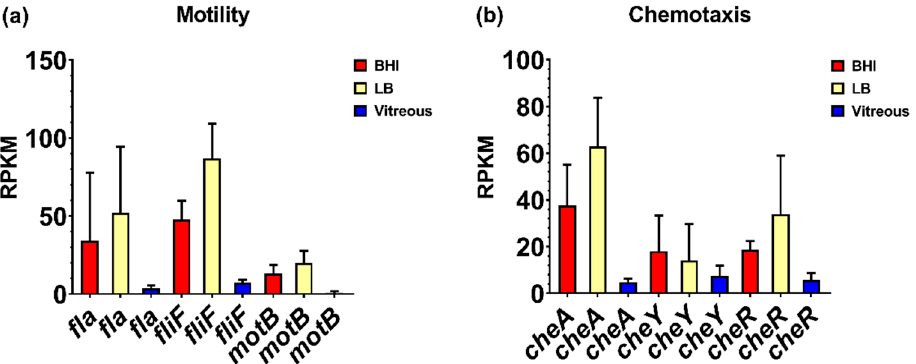
Figure 5. Normalized motility and chemotaxis-related gene expression in each of the three different environments. Reads per kilobase per million (RPKM) for motility-related genes fla , fliF , and motB ( a ), and chemotaxis-related genes cheA , cheR , and cheY ( b ). Brain Heart Infusion broth (BHI) is shown in red, Luria-Bertani broth in yellow, and vitreous in blue. RPKM values are the means ± the standard deviations of three independent RNA-Seq runs.